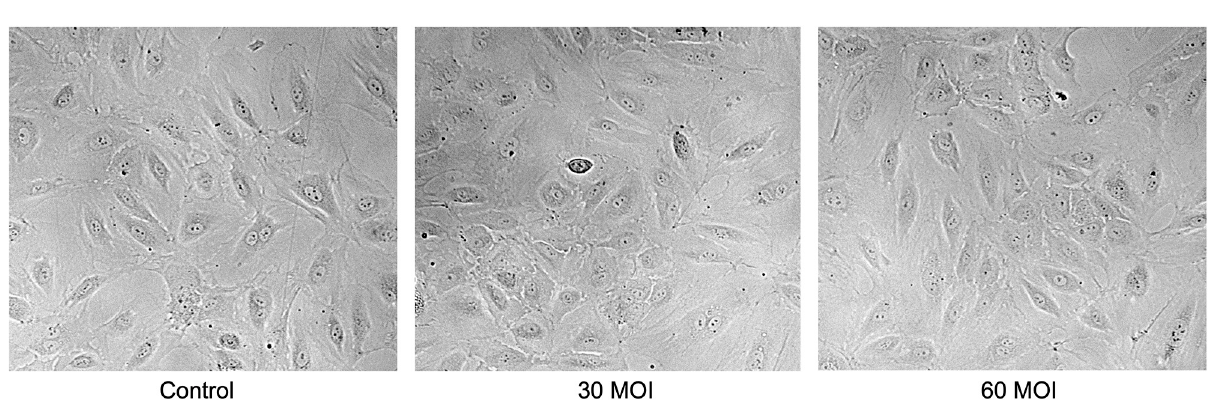
Fig 2. Examining viability of cells. Phase contrast images were taken of the human umbilical vein endothelial cells and showed no overt cytopathology and appeared to be viable.